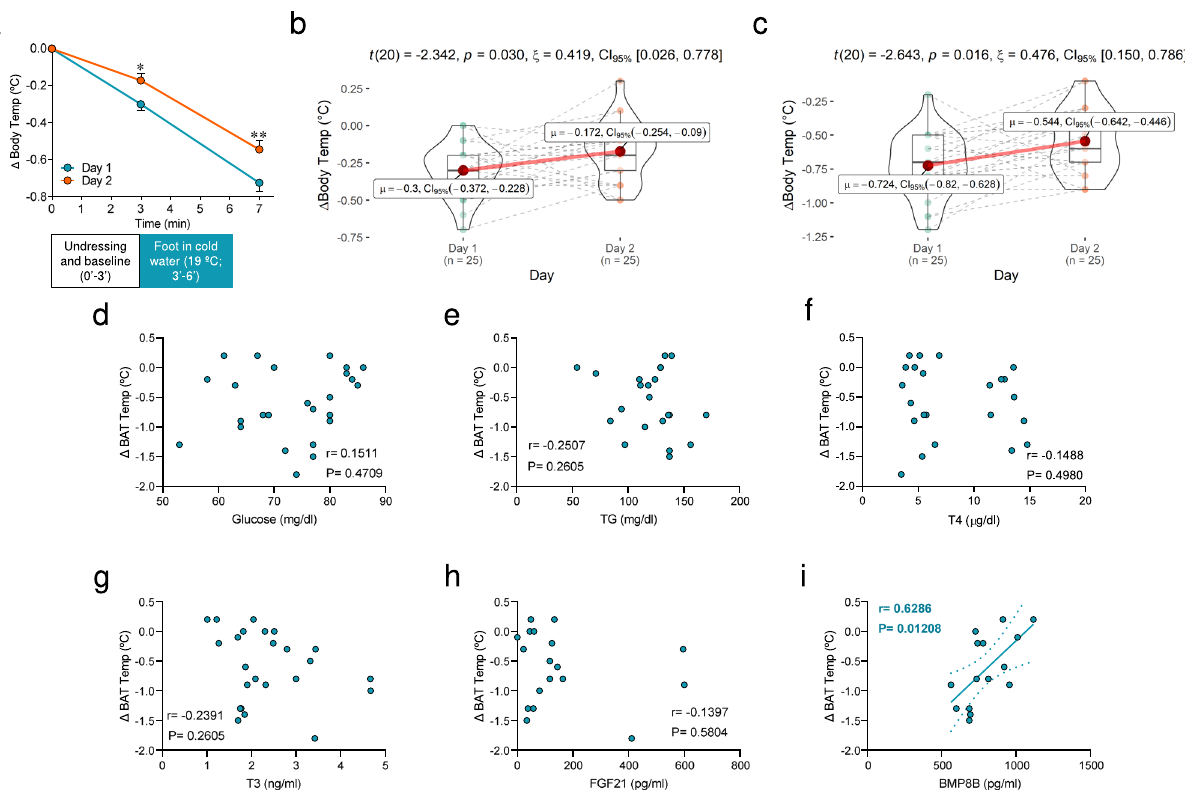
Fig. 7 Cold exposure improves a subsequent thermogenic response in newborns. a Body temperature changes on day 1 and day 2 in cold exposed newborns. A number of newborns/group: 25. Data represent mean ± SEM. t = 3 day 1 vs. t = 3 day 2 P = 0.031; t = 7 day 1 vs. t = 7 day 2 P = 0.0061. b Violin plot showing the individual body temperature changes between minute 3 and minute 7 at day 1 and day 2 in cold exposed newborns. A number of newborns/group: 25. Violin plots indicate median (middle line), 25th, 75th percentile (box) and Q1 − 1.5× IQR (interquartile range) and Q3 + 1.5× IQR (whiskers; minima and maxima, respectively). P = 0.03. c Violin plot showing the individual body temperature changes between minute 0 and minute 7 at day 1 and day 2 in cold exposed newborns. A number of newborns/group: 25. Violin plots indicate median (middle line), 25th, 75th percentile (box) and Q1 − 1.5× IQR (interquartile range) and Q3 + 1.5× IQR (whiskers; minima and maxima, respectively). P = 0.016. Statistical signi fi cance for panels a – c was determined by two-sided linear mixed models followed by contrast of marginal means differences, with P values adjusted by Holm ’ s method. * P < 0.05, ** P < 0.01. d , i Correlation between BAT temperature change and circulating factors in cold exposed newborns at postnatal day 2. Number of newborns/ group: d 25, e 22, f 23, g 24, h 18, i 15. Association analysis was performed by two-sided Pearson ’ s test or Spearman ’ s test; regression line with 95% con fi dence interval was added when correlation was signi fi cant. Source data are provided as a Source data fi